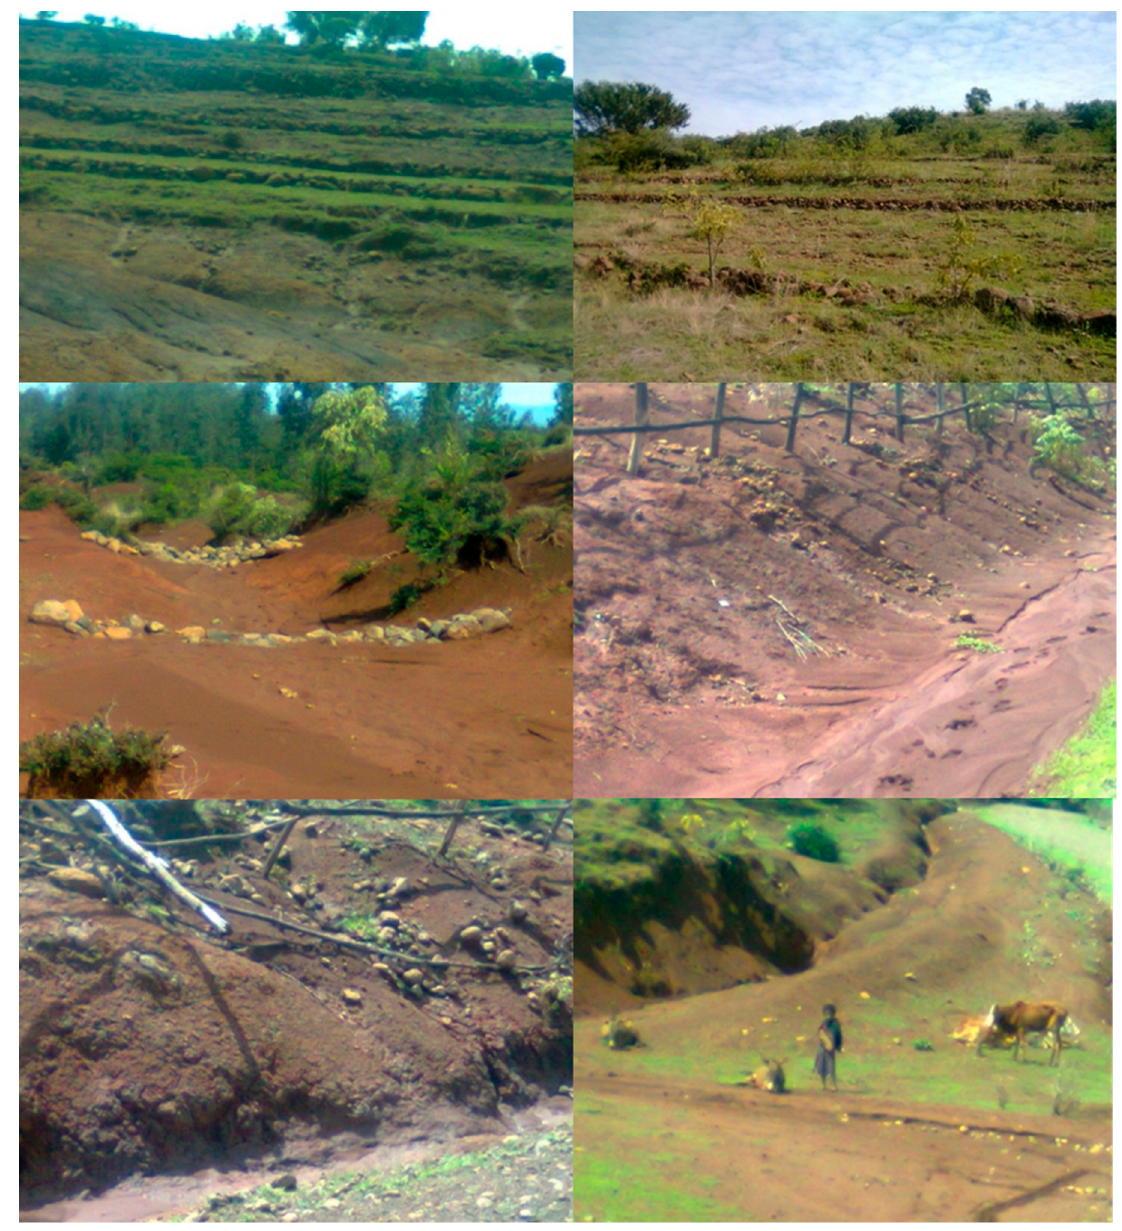
Figure 8. Existing structural soil and water conservation measures in the watershed (photo by Engidasew Z. Teshale, 2012).